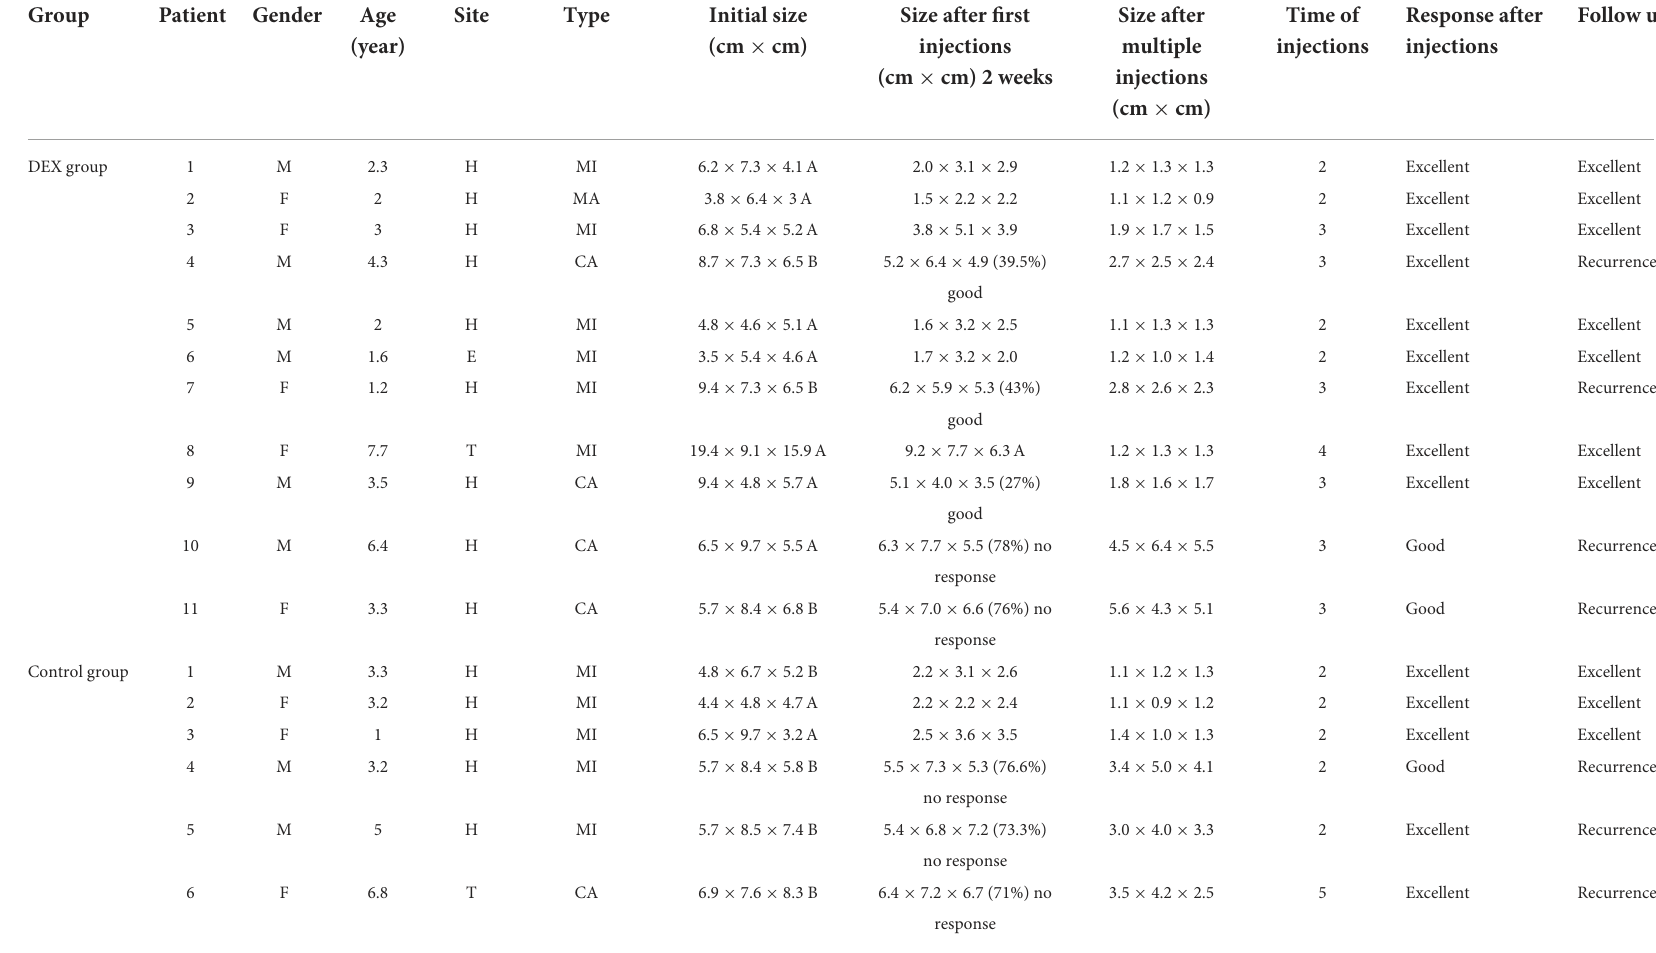
TABLE 2 The characteristics of patients not achieving excellent response after the first injection in the control group.